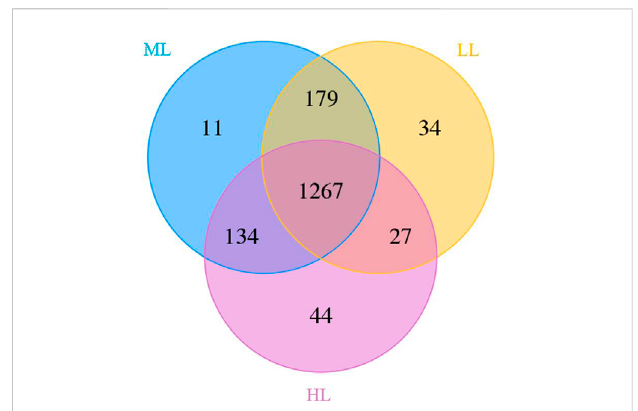
FIGURE 1 Venn diagram of soil bacterial OTUs. LL, low-latitude; ML, mid- latitude; HL, high-latitude.